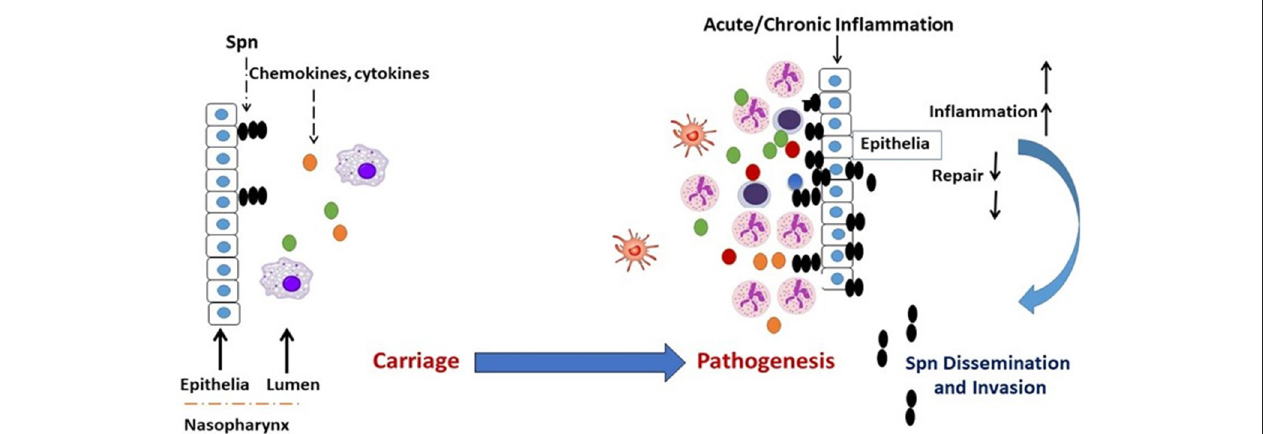
FIGURE 1 | Transition of Spn commensal colonization to disease. Acute or chronic airway inflammation caused by influenza virus or chronic conditions such as COPD or allergic asthma promote Spn bacterial outgrowth and compromises respiratory tissue barrier function, which leads to the invasion of Spn bacteria into the bloodstream establishing invasive infection. Colored dots (green, yellow, red, blue) represent chemokines and